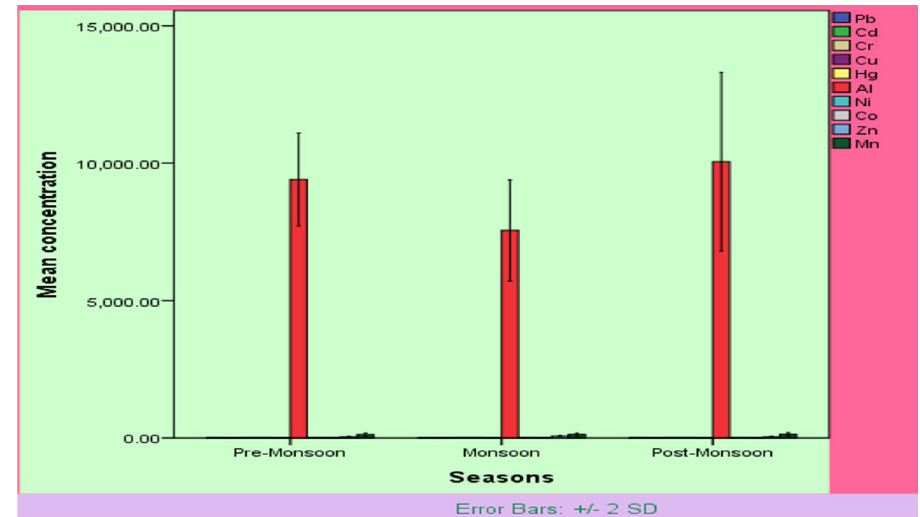
Fig. 3 Graph showing mean concentrations (mg/kg) of heavy metals in sediment during three seasons